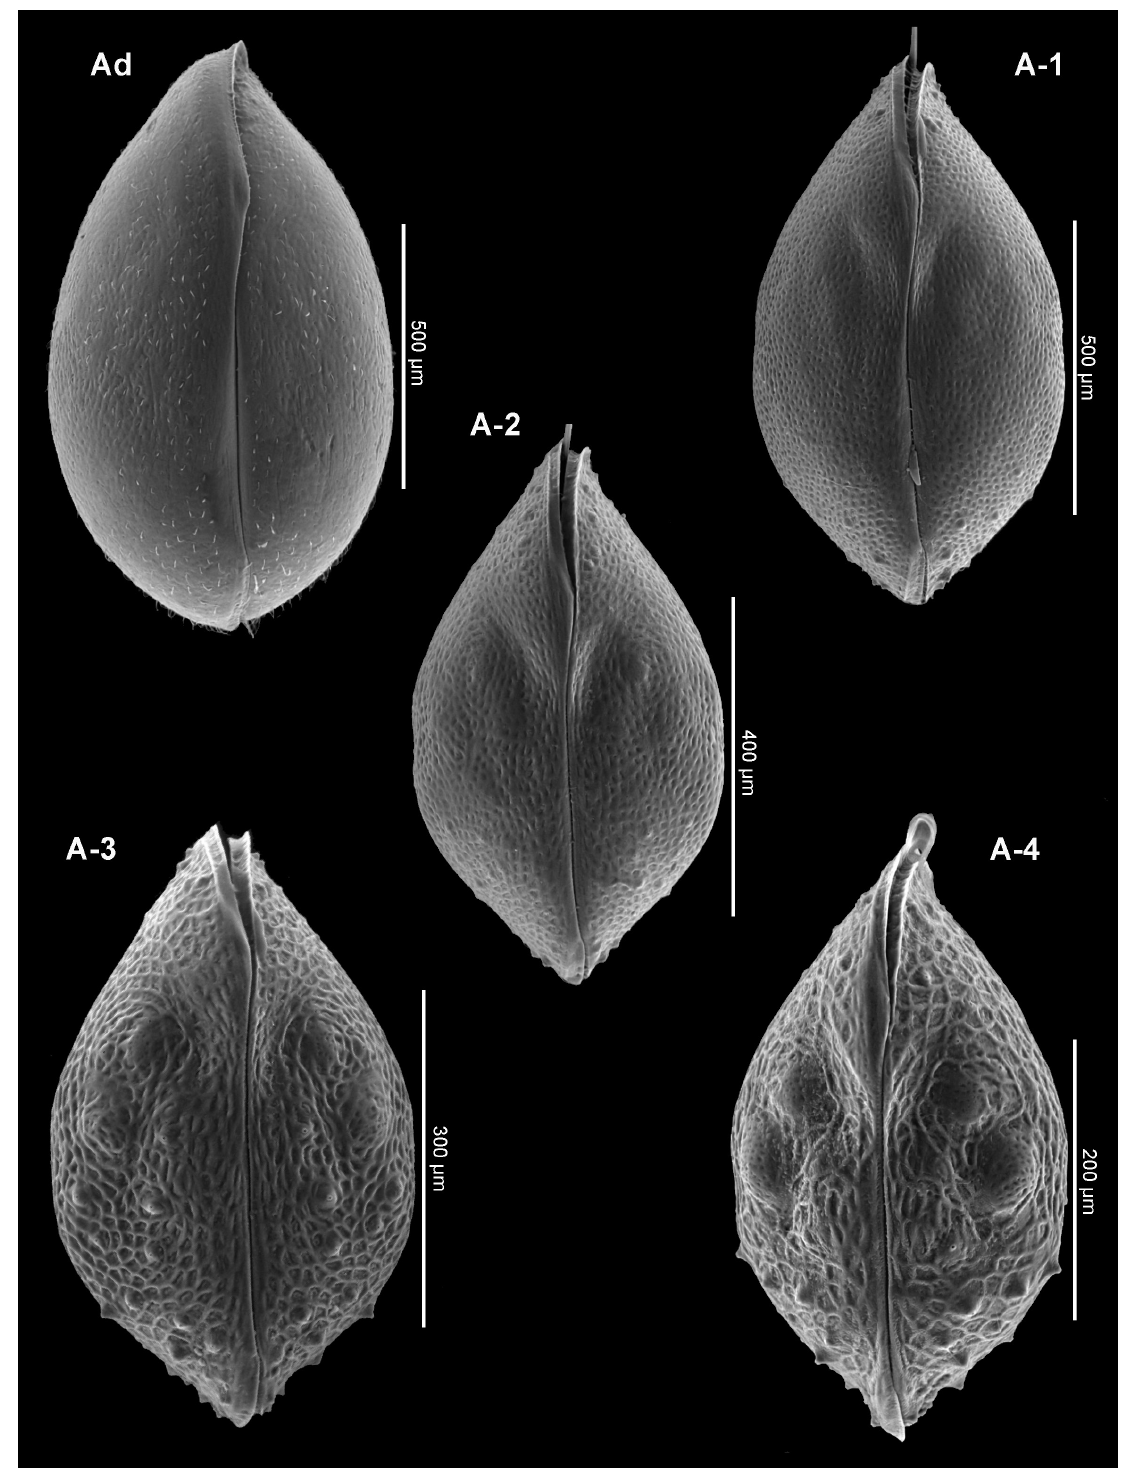
Fig. 19. Dorsal views of carapaces of Bennelongia dedeckkeri Shearn et al ., 2012 from Lake Dunn (Queensland) for the last 4 instars (A-4 to A-1) and the adult to show the changes in external ornamentation and the progressive disappearance of the domes and cones with ontogeny, such that at the adult stage, there is no ornamentation. Observe the presence of outer lists in all juvenile specimens clearly visible in the antero-dorsal